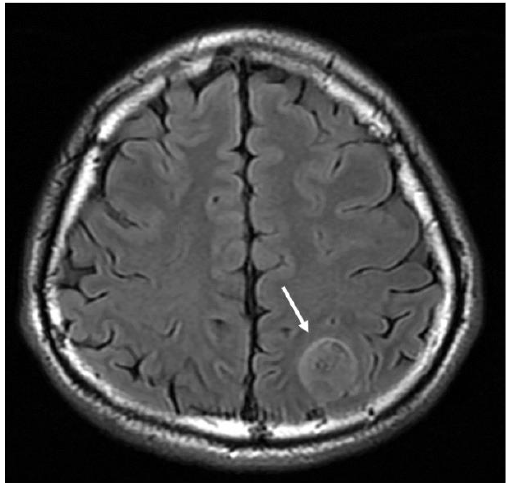
Figure 2. MRI T2-weighted fluid attenuation inversion recovery (FLAIR) axial image demonstrates a hyperintense mass lesion